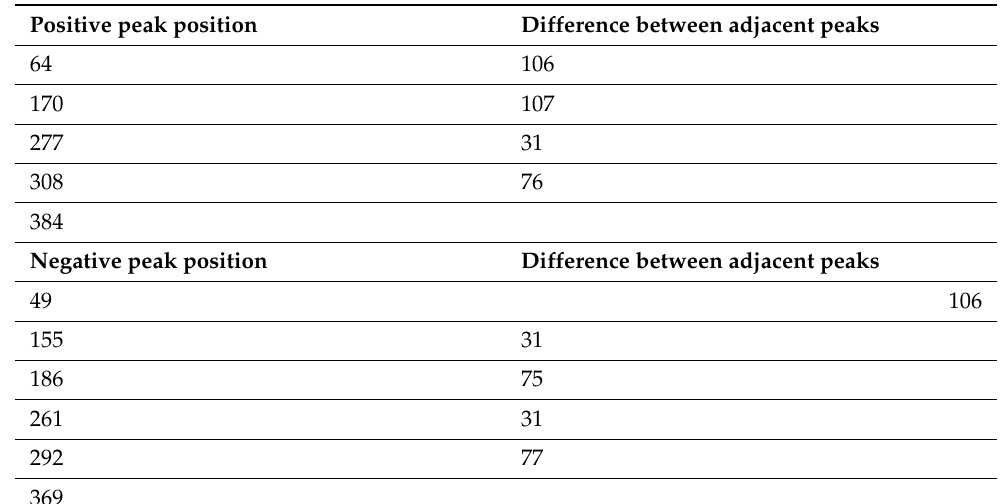
Table 1. Positive and negative peaks’ positions in the 65th frame in the digit sequence “seven six one three” and differences calculated between adjacent